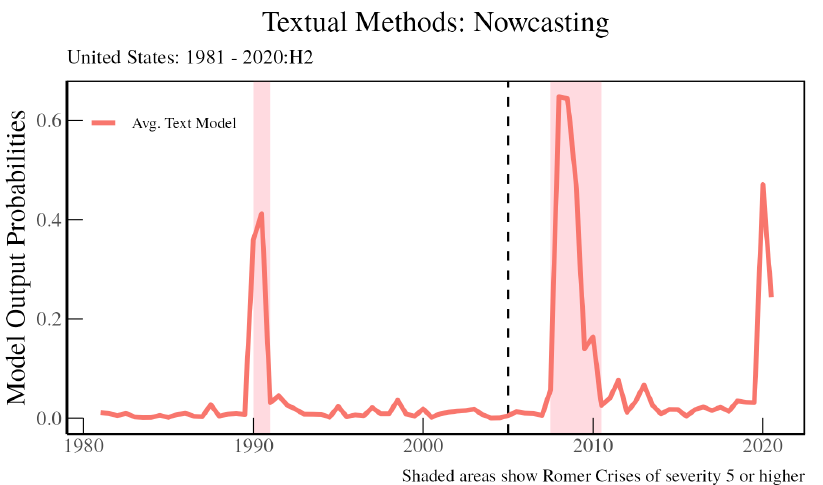
Figure 12. Average Text Model Output for United States . Note: This figure shows nowcasting results of model probability for a Romer and Romer (2017) 5+ severity crisis in the US (model trained on OECD text from 1981–2004). Periods indiacted as a Romer and Romer 5+ crisis are shaded in pink. The figure shows a spike in the probability of a crisis in the first half of 2020. Because the Romer and Romer crises dataset ends in 2012, the post-2012 predictions here are completely